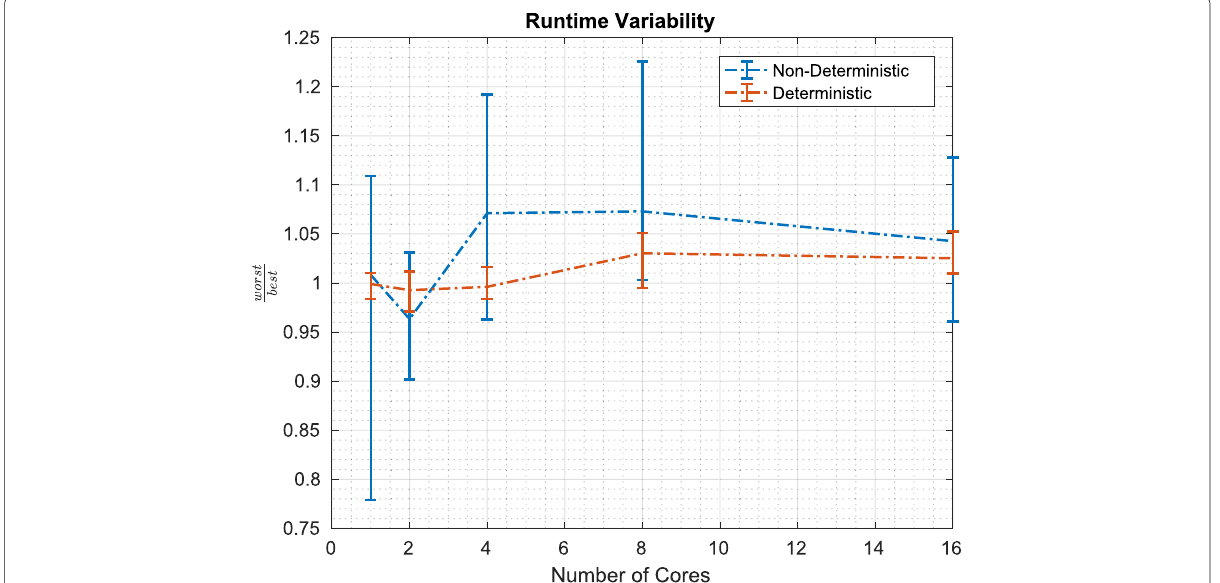
Fig.7 Ratio of average (and minimum and maximum) runtimes for worst-case and best-case scenarios using the deterministic and naïve